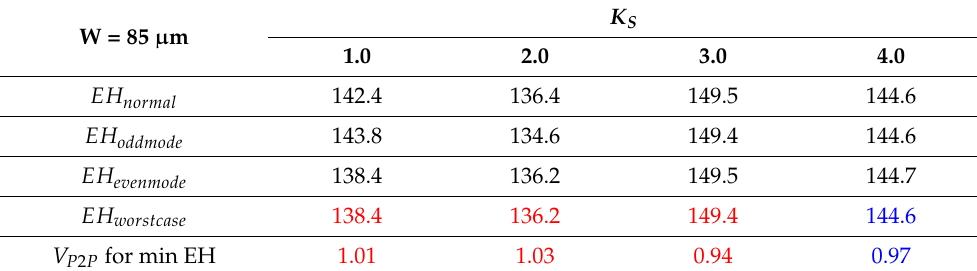
Table 6. Eye diagram simulation against K S in the stripline